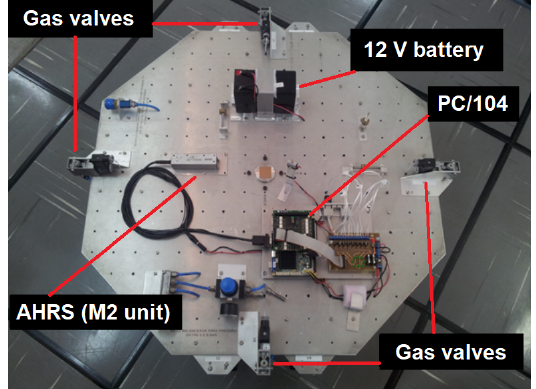
Figure 3. Semispherical 3-DOF air bearing, available at